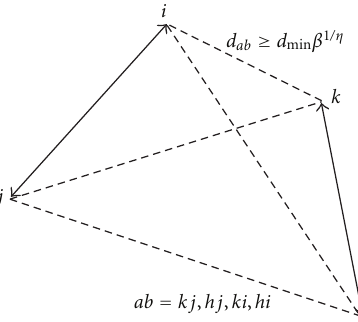
Figure 8: SINR model of interference.